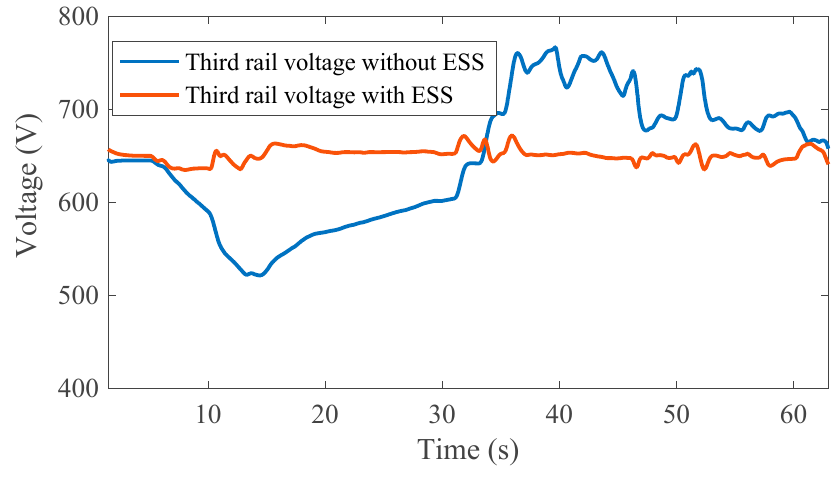
Figure 13. Voltage regulation.